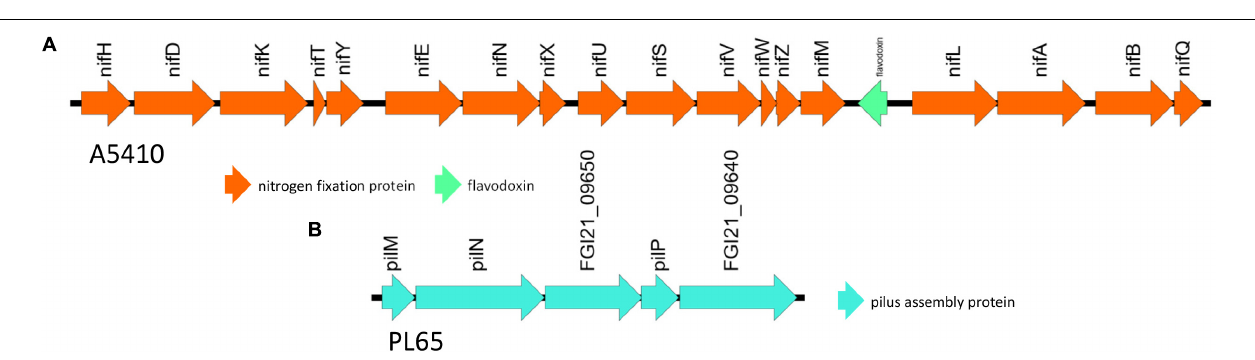
FIGURE 7 | The unique gene clusters present in D. zeae strains. (A) The nitrogen fixation cluster from genome A5410. (B) The pilus assembly protein cluster from